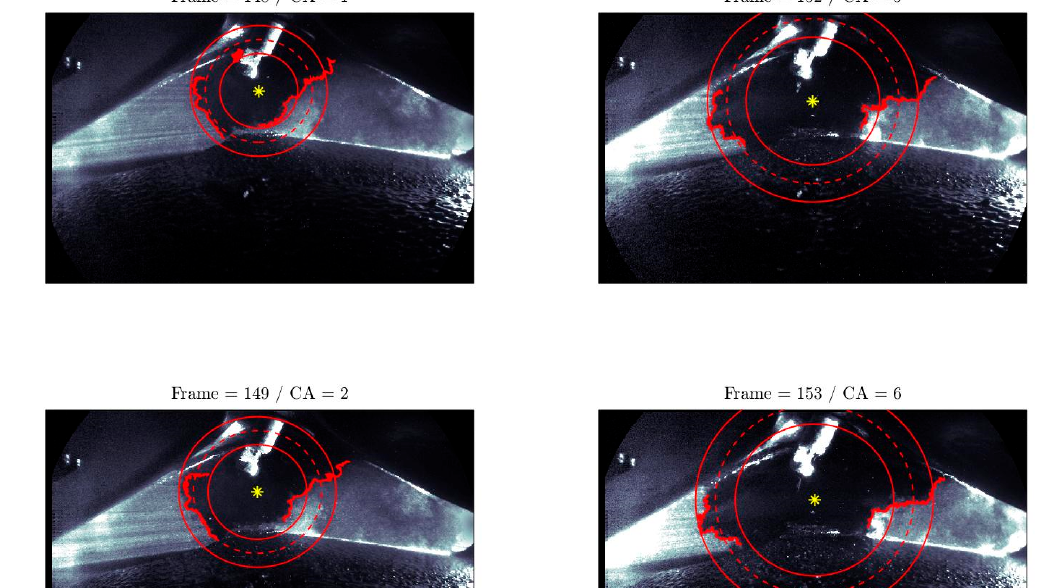
Figure 13. Cycle 59. Background corrected images of turbulent flame from − 7 CAD to TDC firing. Superimposed geometric properties: flame edges, flame center, min, max, and average radii. Engine operation: 1000 RPM, wide open throttle.